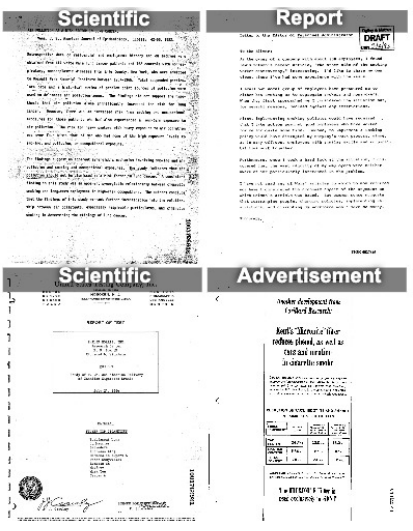
Figure 13. This figure portrays two different scenarios in which the class Scientific resembles other classes such as Report and